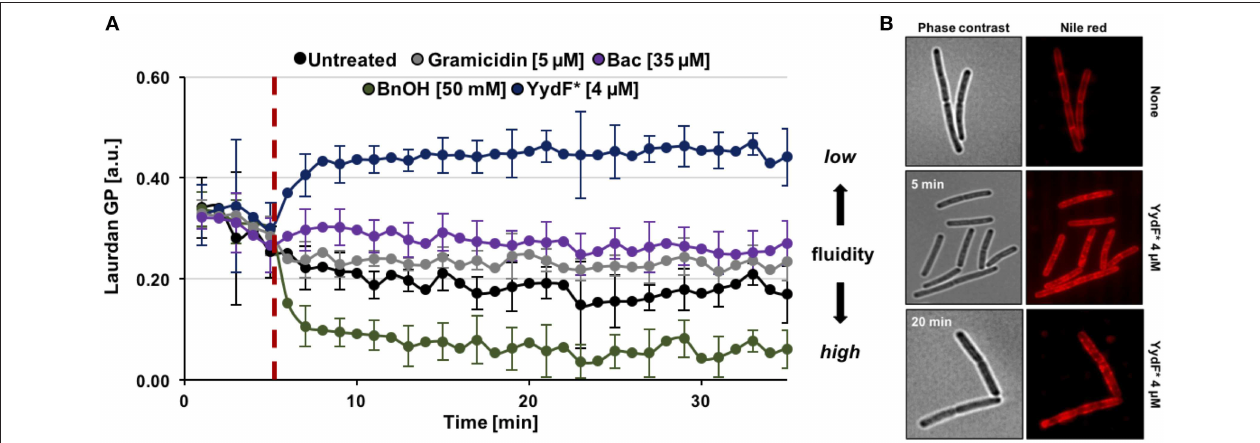
FIGURE 6 | YydF* causes membrane rigidification and lipid domain formation. (A) Measurement of generalized polarization (GP) values using the fluidity sensitive fluorescent probe laurdan. Higher laurdan GP values correlate with rigid membrane state. Cells were incubated for 5min to obtain basal GP levels, followed by addition of compounds (dashed red line). Benzyl alcohol was used as positive control for increased membrane fluidity, i.e., drop of GP values (green line). Non-treated, gramicidin, and bacitracin showed no effects on the fluidity state of the membrane (black, gray, and purple lines). Addition of 4 µ M YydF* lead to a rigidification of B. subtilis cell membranes, indicated by elevated GP values (blue line). (B) Phase contrast and fluorescence images of B. subtilis cells stained with the membrane dye nile red after 5 and 20min incubation with 4 µ M YydF*,